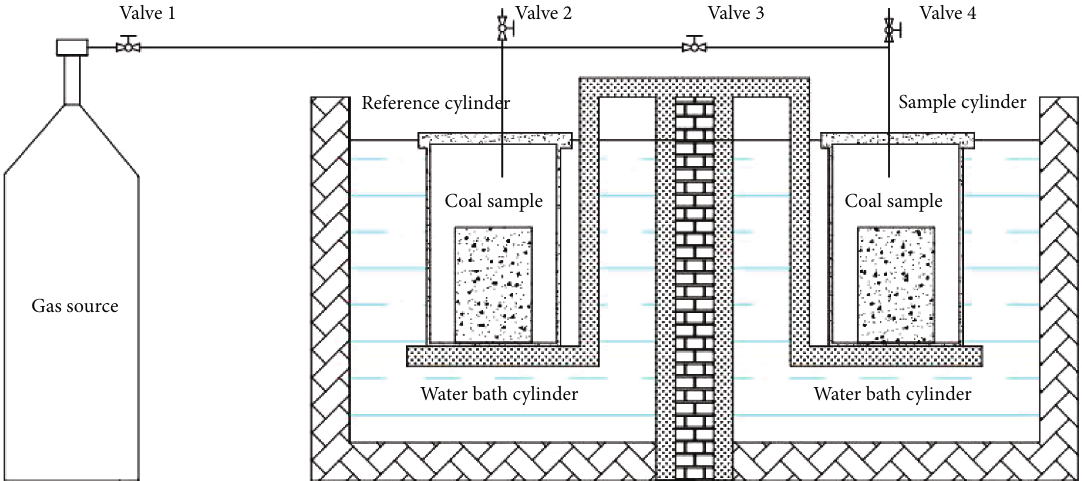
Figure 1: Diagram showing the system used to measure the gas adsorption capacity of coal samples.